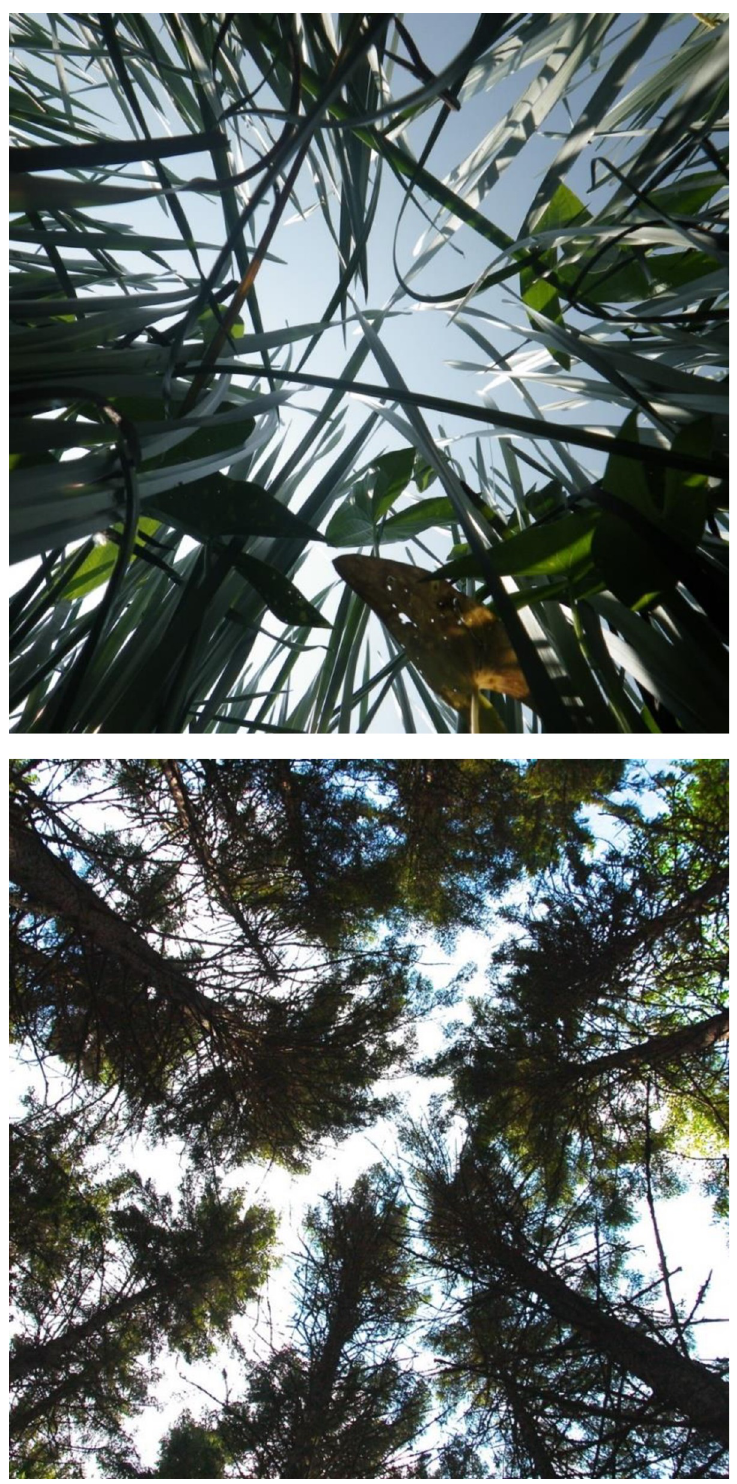
Fig 3. Photographs of herbaceous and forest stands taken from underneath to illustrate their similarities in leaf cover (Photo credit R. Proulx and C. Martin.).